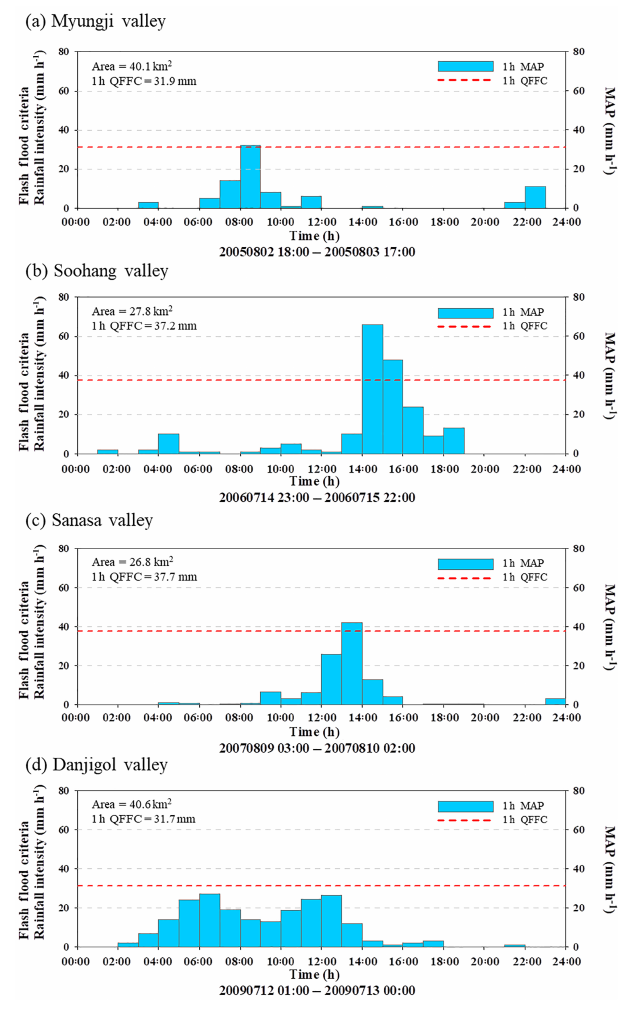
Figure 11. Validation of quantitative flash flood criteria.